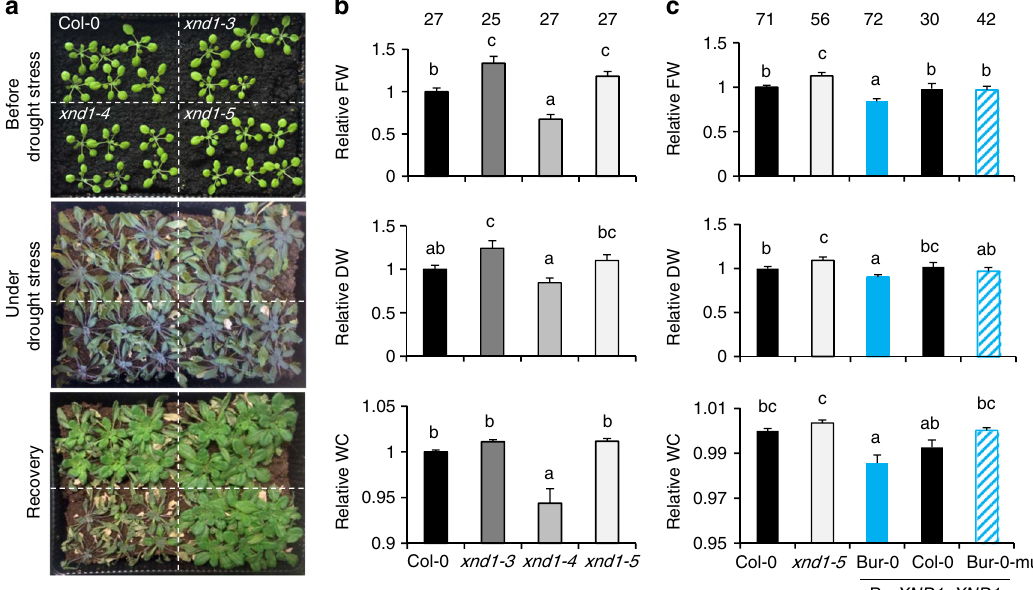
Fig. 6 XND1 negatively regulates plant drought stress tolerance. a Shoot phenotypes of Col-0 and xnd1 plants at 22 days postgermination (upper panel), after water deprivation for 24 additional days (middle panel), and at 5 days after rewatering (lower panel). b Relative fresh weight (FW), dry weight (DW) and water content (WC) in shoots of indicated genotypes at 5 days after rewatering (see a ). All data were normalized to values measured in Col-0 plants from the same pot. The fi gure shows mean values ± SE from the indicated number of plants and four biological replicates. One-way ANOVA (Fisher ’ s LSD, P < 0.05) was used to test the signi fi cance of the data. c Same parameters as in b but for Col-0, xnd1 – 5 , and xnd1 – 5 plants complemented with the Bur-0, Col-0, or Bur-0-mut XND1 alleles. Three to fi ve independent transgenic lines were phenotyped for each allele. Mean values± SE from the indicated number of plants are shown. One-way ANOVA (Fisher ’ s LSD, P < 0.05) was used to test the signi fi cance of the